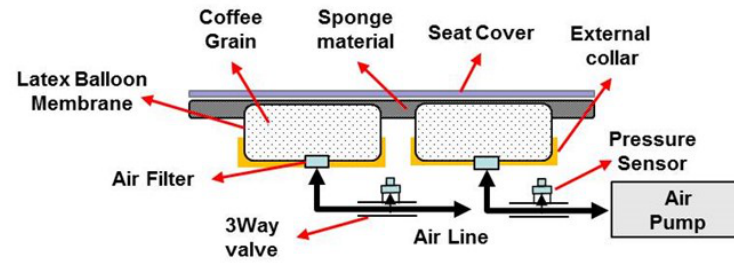
Figure 2. Initial concept of SSA seats system.